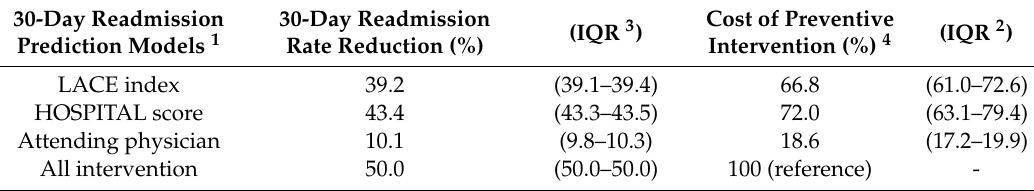
Table 3. Thirty-day readmission rate reduction and cost of preventive intervention by the LACE index and HOSPITAL score prediction models and all intervention model compared to the attending physician model. Simulated results of acute hospitalizations of a home care patient cohort of a medical center a ffi liated home care unit in Taiwan, 2017 ( n =